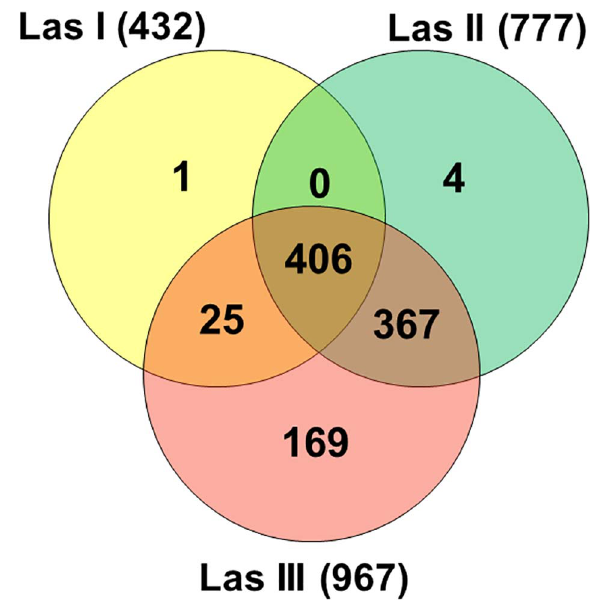
FIGURE 1 | Venn diagram of “ Candidatus Liberibacter asiaticus” genes with mapped reads (strain JXGC, NZ_CP019958.1) in Diaphorina citri gut samples after acquisition access periods of 1/2 days (Las I), 3/4 days (Las II), or 5/6 days (Las III).